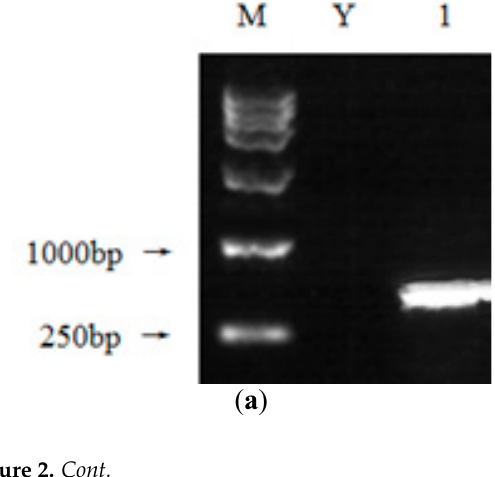
Paecilomyces lilacinus (GQ229080.1) Figure 2.